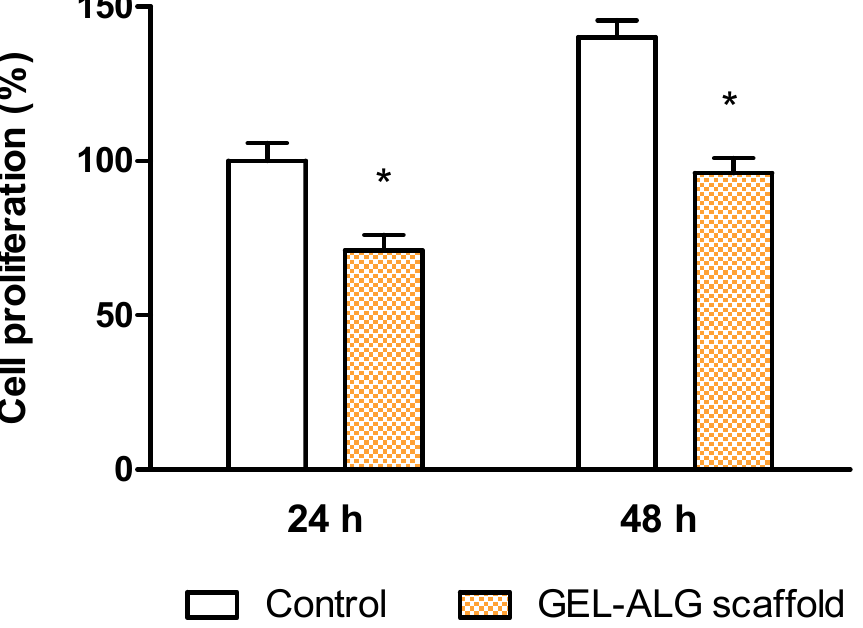
Figure 5. Viability of 3T3 fibroblasts evaluated by the MTT test at 24 h for control and GEL–ALG scaffold. Viability rate in control was considered as 100%. Results are expressed as mean ± SD from triplicate experiments. * p < 0.05 .